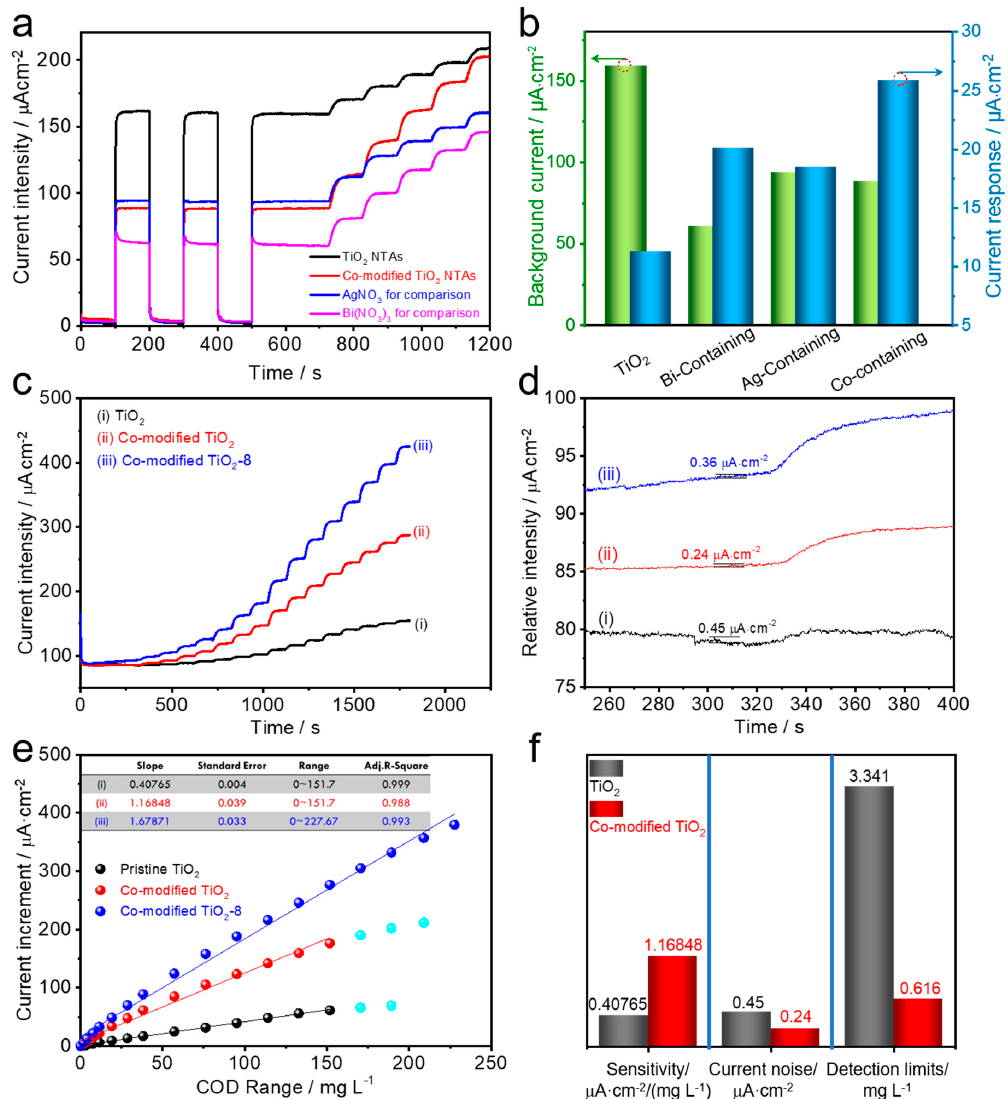
Figure 5. Photoelectrochemical (PEC) properties’ characterization. ( a , b ) Photocurrent and current response of TiO 2 and the co-modified TiO 2 NTAs. Amperometric response of the constructed PEC sensors to the continuous addition of glucose in PBS: ( c ) current intensity-time curve, ( d ) current noise obtained from the high-resolution curve of ( c ), ( e ) plots of current increments vs. chemical oxygen demand (COD) range, and ( f ) comparison of detection performances.